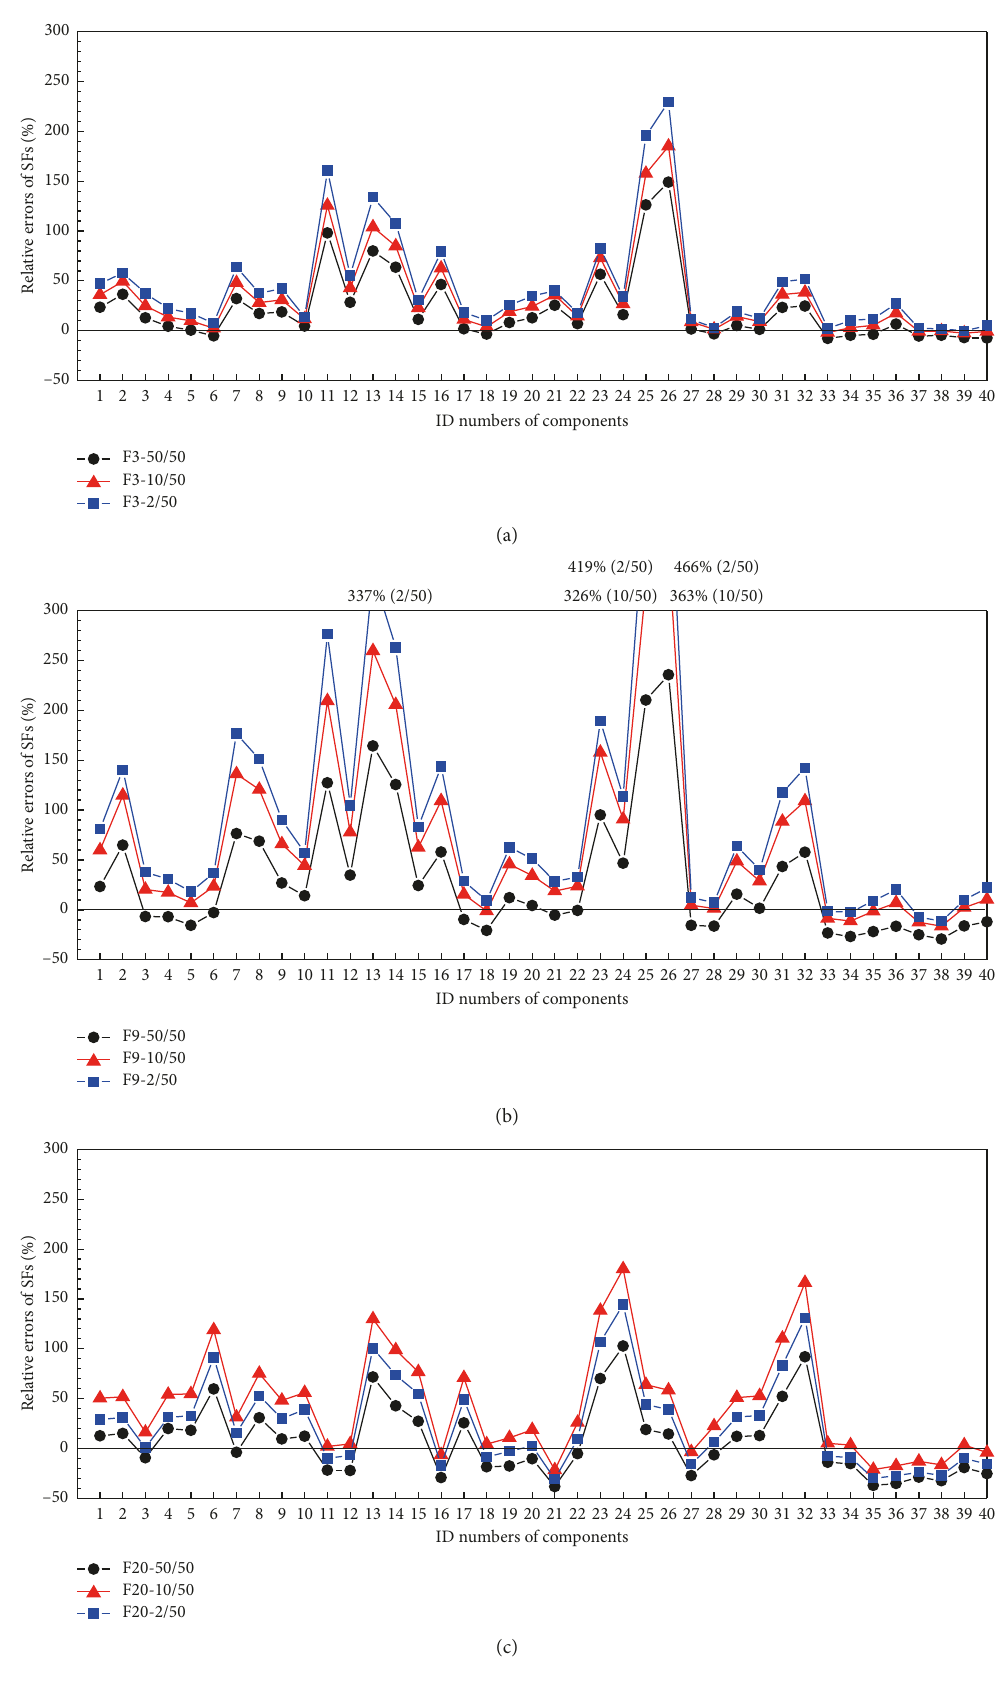
Figure 2: . Comparison of the relative errors of SFs between the ASM and LSM methods: (a) 3-story structure, (b) 9-story structure, and (c) 20-story